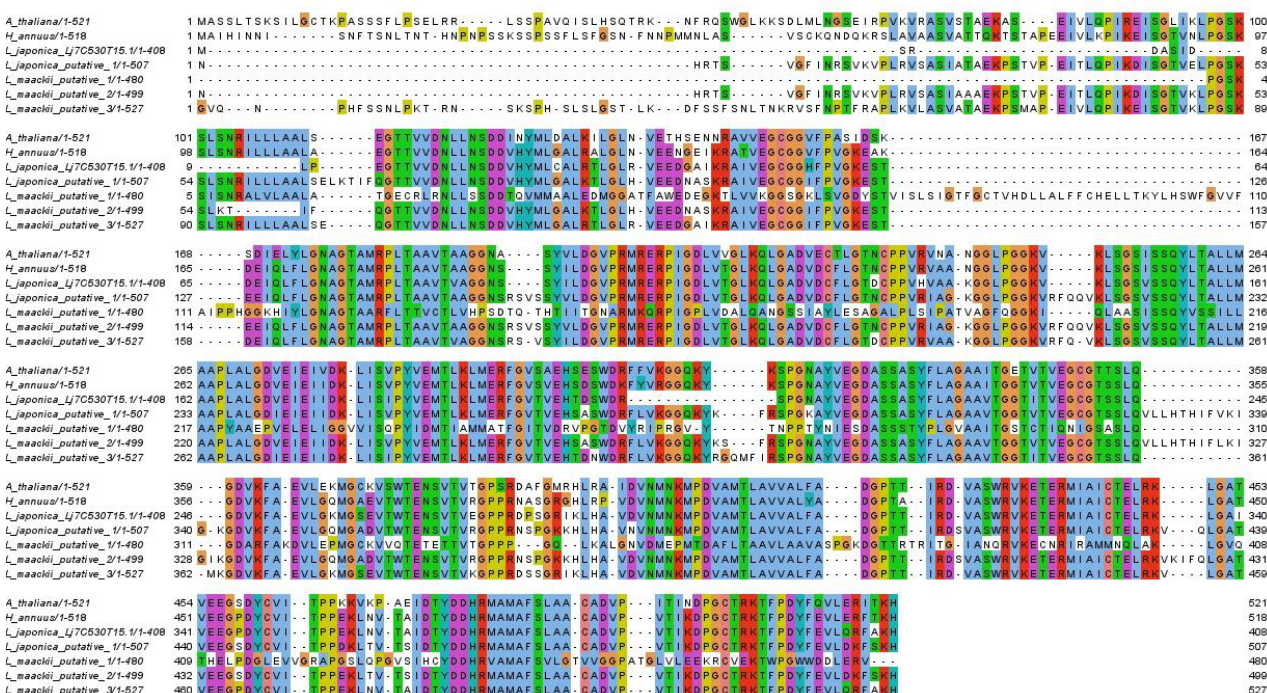
Figure 2. Alignment of known and predicted EPSP synthase protein sequences. Sequences are iden- tified by species name. Proteins predicted through sequence homology are named as “putative”.